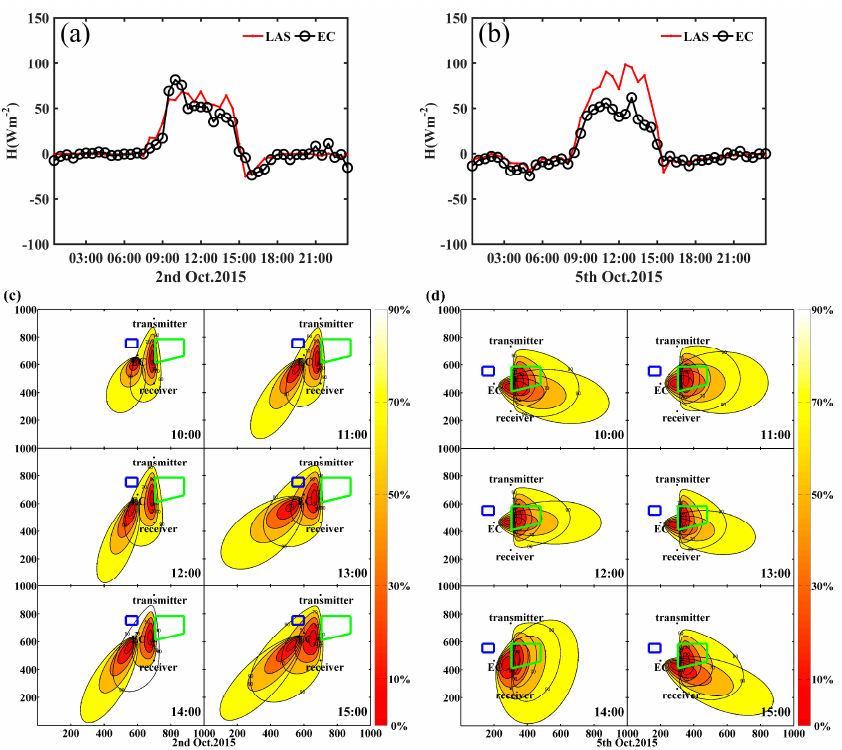
Figure 10. Variations of H LAS and H EC on 2 ( a ) and 5 October ( b ). Footprints of sensible heat fluxes measured by EC and LAS systems on 2 October ( c ), and on 5 October ( d ). The blue rectangle represents the grove field, and the green trapezoid represents the mulberry seedling field. Additionally, the corresponding time is marked in the lower right corner of picture.